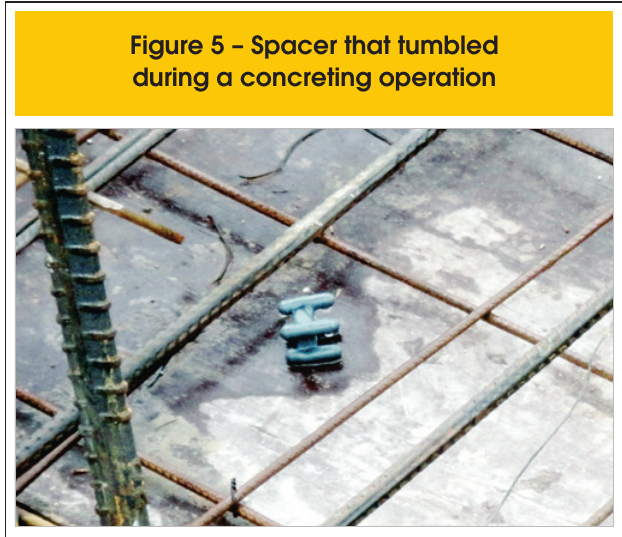
Figure 6 – Deformation of the spacer because of the load in